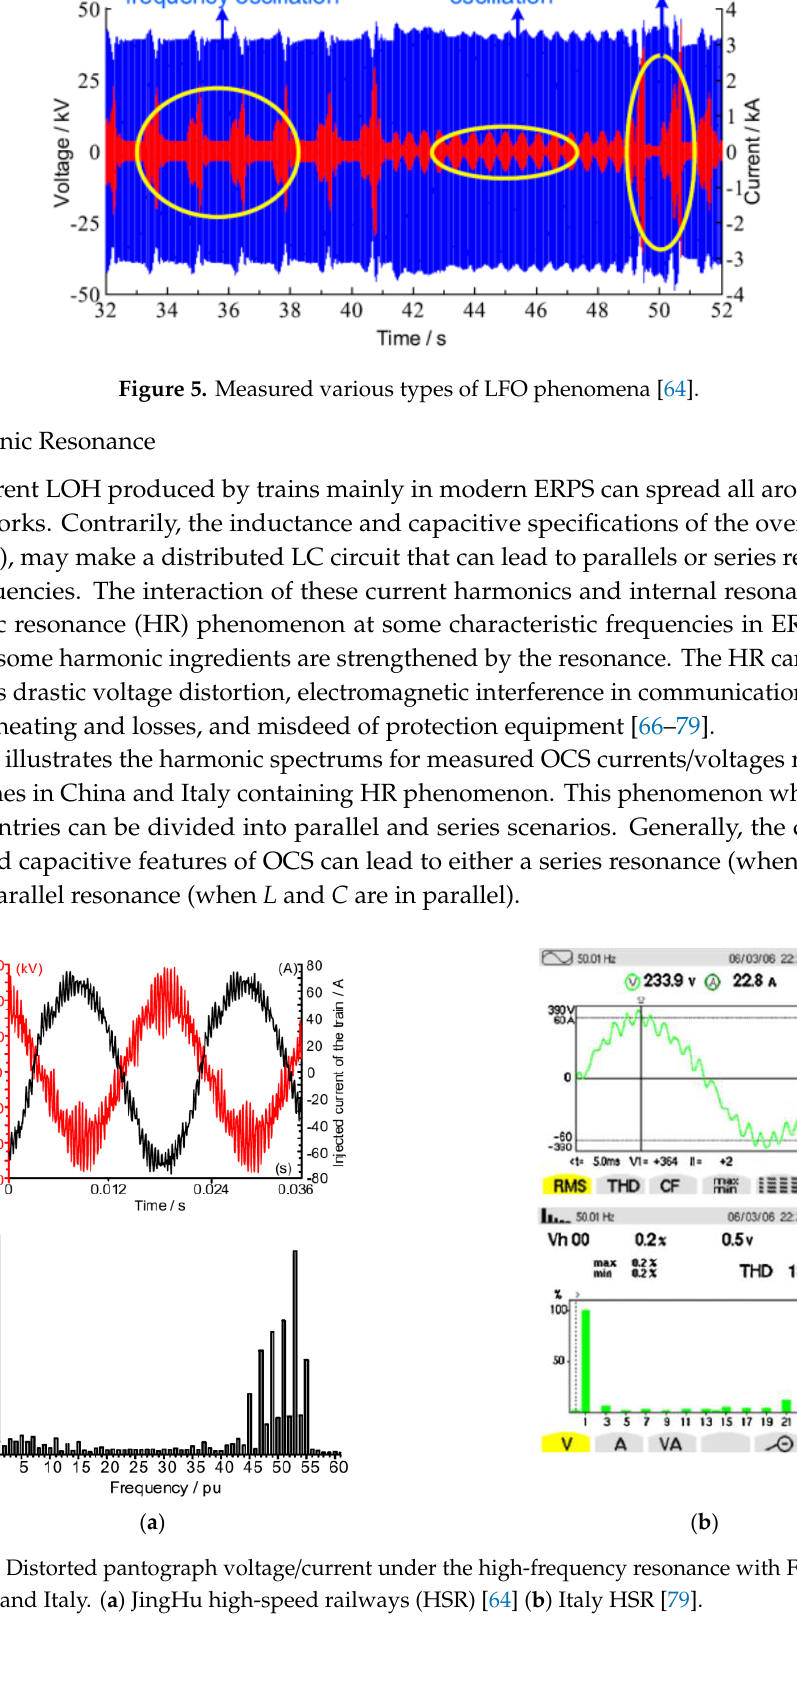
specification of multi-conductor OCS. The specified frequency oscillation range for PHR based on measurements is between 10 and 55 p.u. The critical HR incidents correlate with the parallel